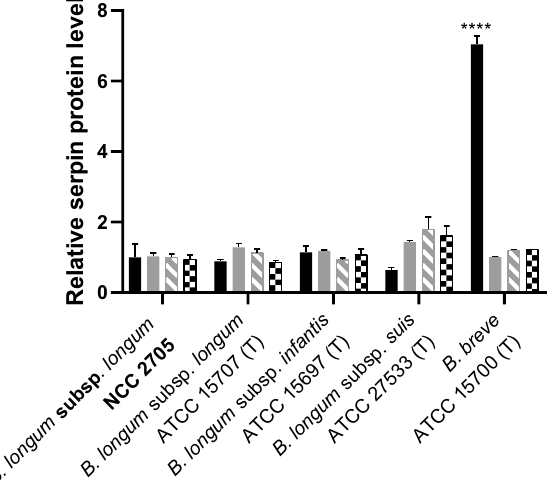
Figure 1. Effect of different proteases (papain [black bars], trypsin [grey bars], chymotrypsin [dashed gray bars] and pig pancreatic elastase [PPE, squared black bars]) on the serpin production levels in bifidobacteria harboring the serpin encoding gene, after 16 h of growth. The studied strains are B. longum subsp. longum NCC 2705, B. longum subsp longum ATCC 15707 (type strain [T]), B. longum subsp. infantis ATCC 15697 (T), B. longum subsp. suis ATCC 27533 (T) and B. breve ATCC 15700 (T). Serpin levels are expressed relative to the control level (including standard deviations) measured in MRS without addition of proteases. Statistical difference relative to the control cells are indicated; **** p <